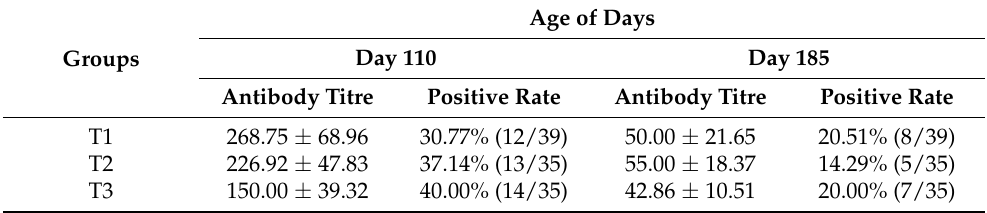
Table 1. The antibody titre and antibody-positive rate in pigs at different doses of the SS DNA vaccine.